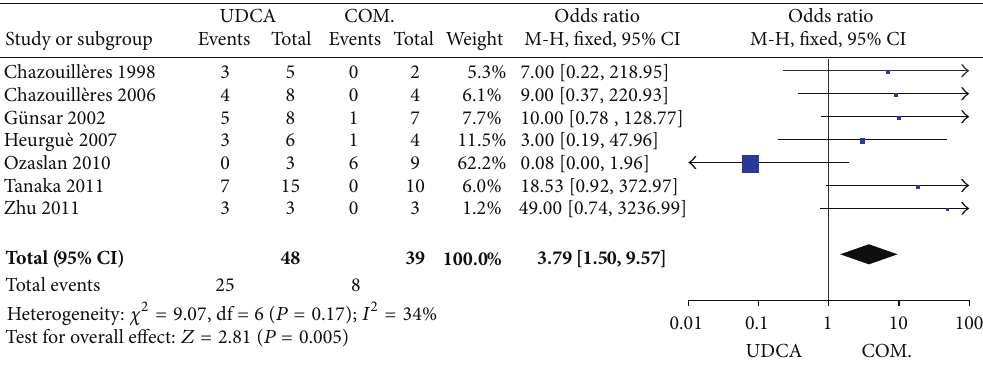
25 of 48 patients in the monotherapy groups and in eight of 39 patients in the combination therapy groups. There was no significant heterogeneity ( 𝑃 = 0.17 , 𝐼